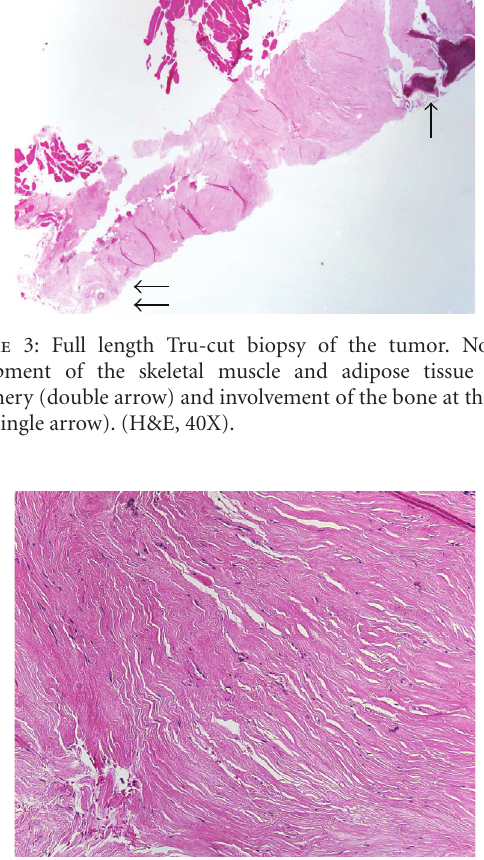
Figure 4: Hypocellular densely collagenous stroma of the tumor.